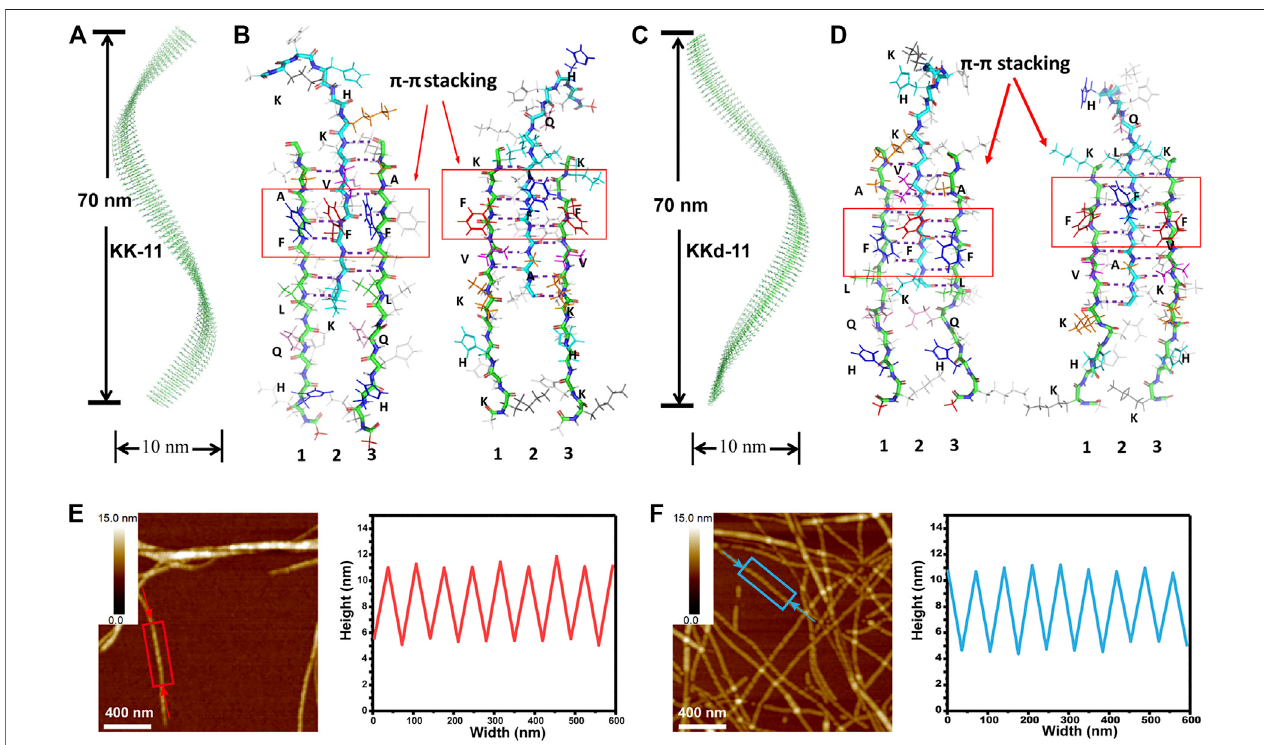
FIGURE 5 | (A) The constructed right-handed helical KK-11 fi bril with a pitch of 70 nm and a width of 10 nm. (B) Inter-stand packing modes of three KK-11 molecules. The hydrogen bonds formed between the hydrophobic region (LVFFA) are shown and the π - π stacking is highlighted with red rectangles. The right three peptides were obtained by rotating the left three peptides 180 ° to illustrate both sides of the amino acids ’ sidechain clearly, with the side that opposite to the reader colored by light grey. (C) Left-handed helical KKd-11 fi bril with a pitch of 70 nm and a width of 10 nm. (D) Inter-stand packing modes of three KKd-11 molecules with similar hydrogen bonding and π - π stacking as (B). The left and right panels were obtained with the same procedure as (B). (E) AFM image (left) of fi brils self- assembledwithKK-11andlinearsectionanalysis(right)ofthepeptide fi brilhighlightedwitharectangleintheAFMimage;(F)AFMimage(left)of fi brilsself-assembledwith KKd-11 and linear section analysis (right) of the peptide fi bril highlighted with a rectangle in the AFM image. The arrows in (E) and (F) indicate the starting and ending points of the section analysis